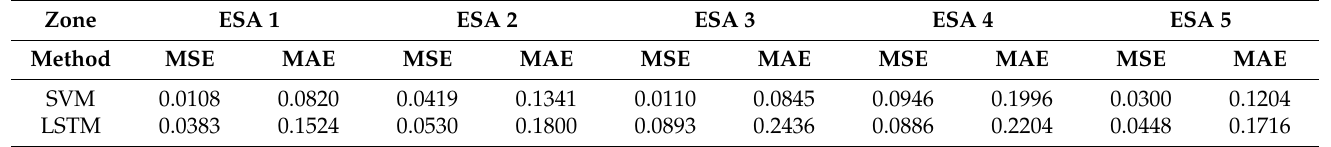
Table 3. MSE and MAE obtained by each simulation method on every